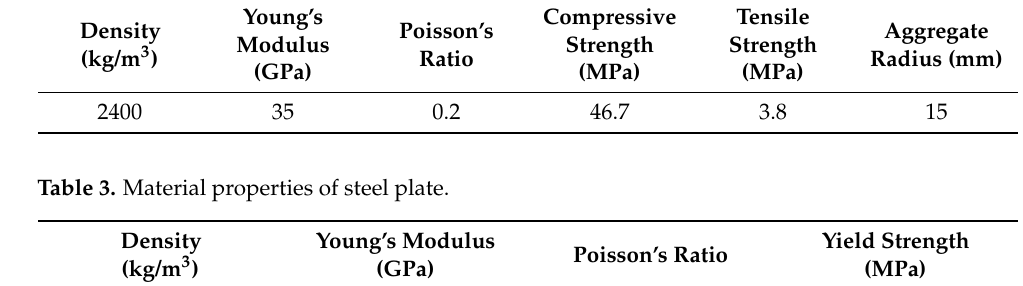
Table 2. Material properties of concrete.